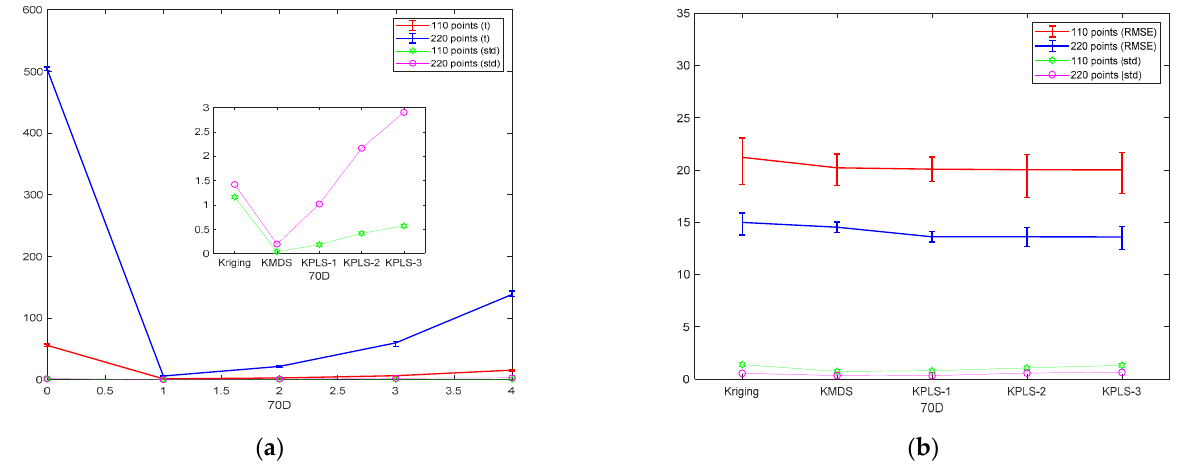
Figure 6. ( a ) Modeling time and its standard deviation for the 70D Griewank function. ( b ) RMSE and its standard deviation for the 70D Griewank function.